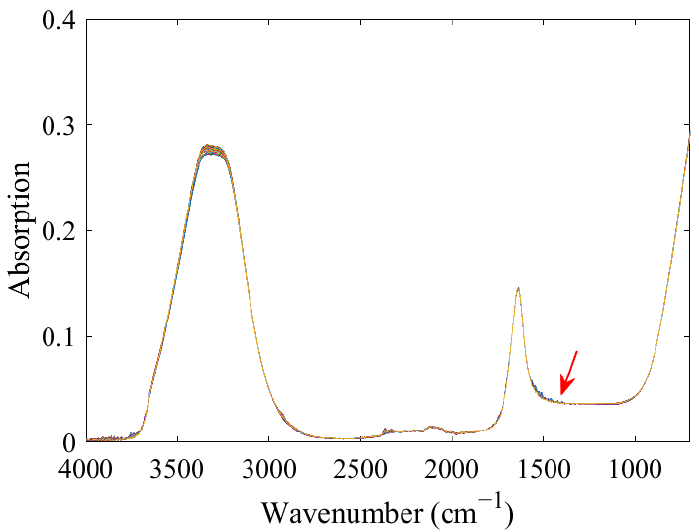
Figure 1. FTIR-ATR spectra of 14 NO 3 − and 15 NO 3 − mixtures with different proportions